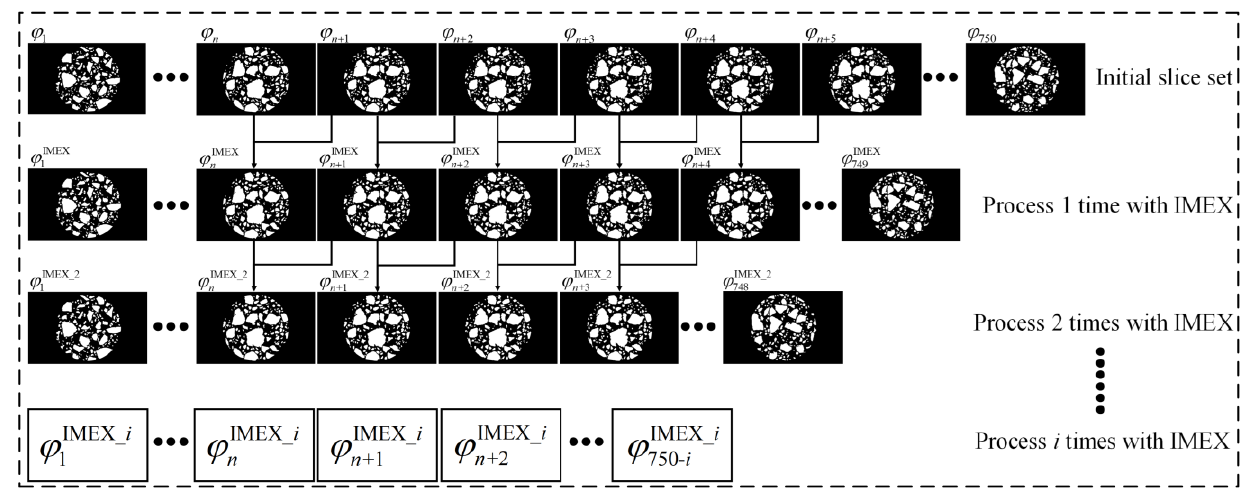
Figure 5. Schematic diagram of the multiple-correction method.